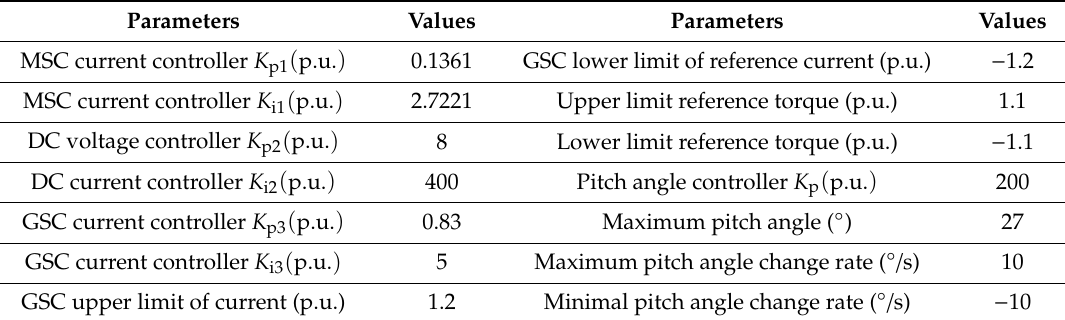
Table 2. Controller parameters of 1.5-MW PMSG wind turbine.